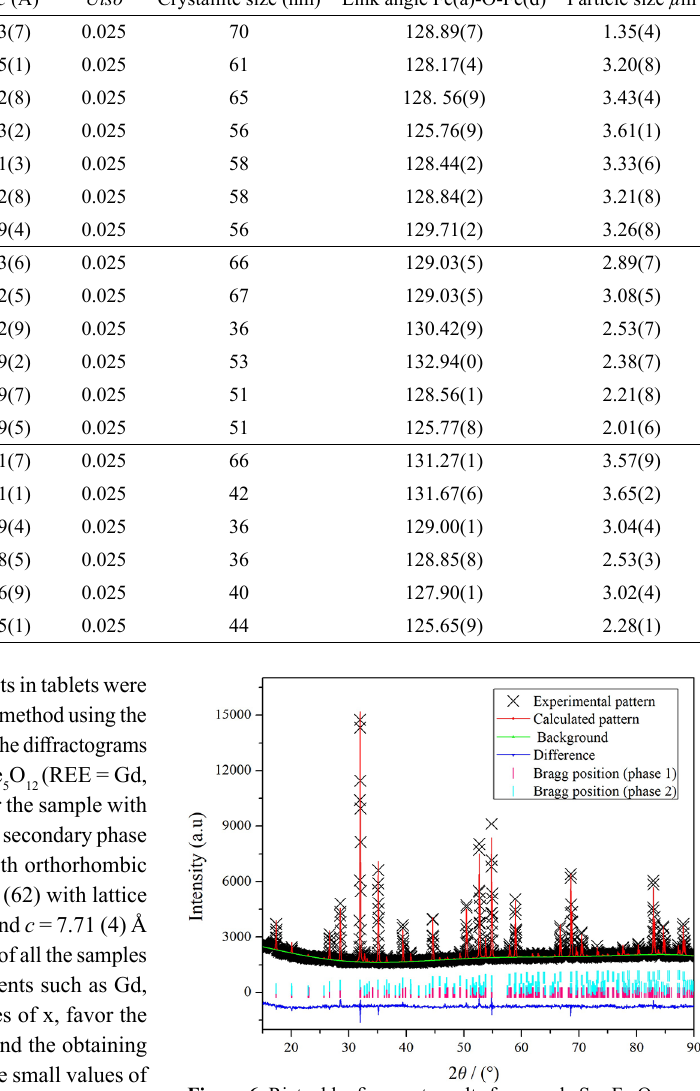
Table 1. Rietveld refinement results obtained from the XRD patterns of the garnet-type Sm REE X Value X 2 R(%)